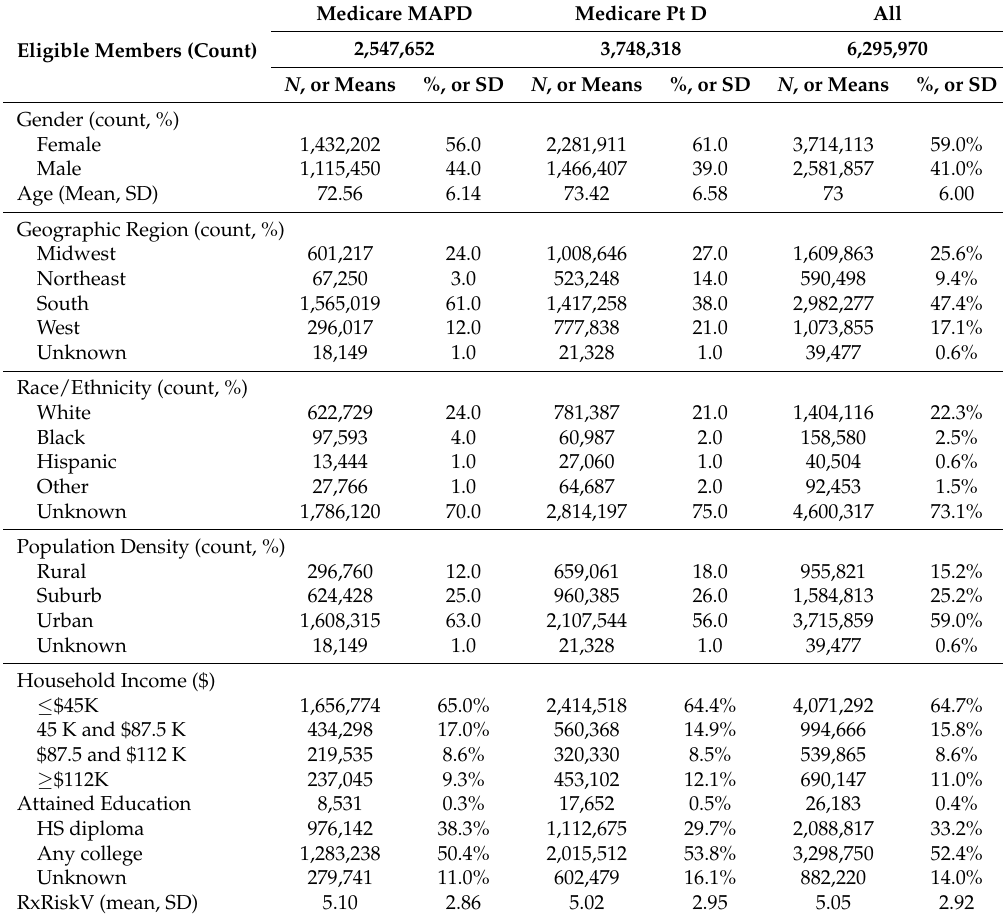
Table 1. Baseline Demographic Characteristics of Herpes zoster (HZ) Vaccine Eligible Adults by Coverage Type. MAPD: Medicare Advantage/Part